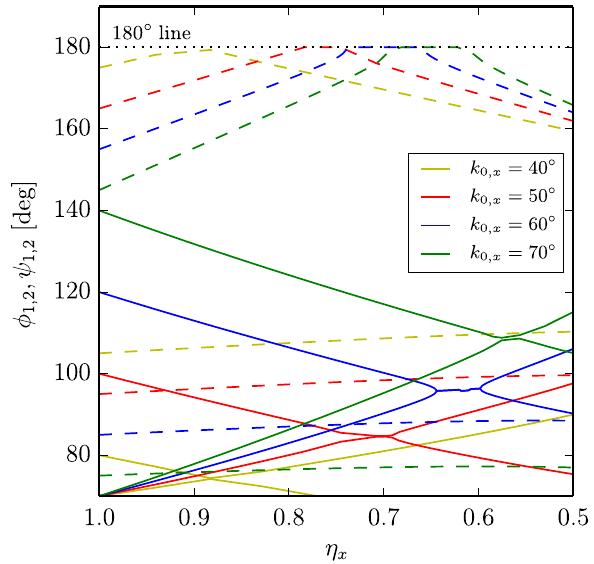
FIG. 10. Enlarged scans of the two opposite corner zones in Fig.